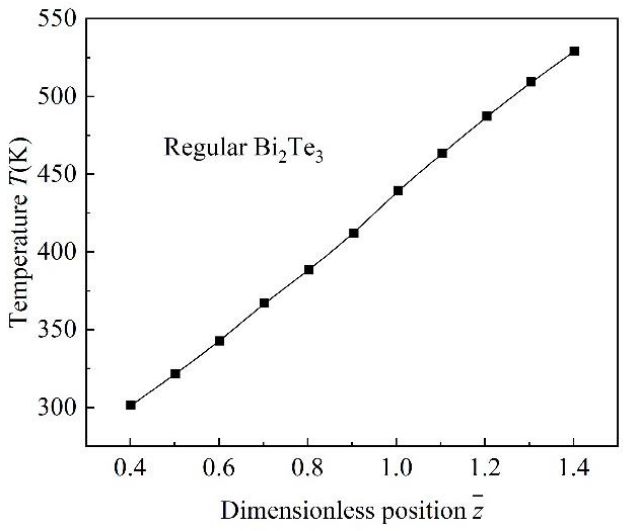
Figure 5. Temperature distribution of TTEG.